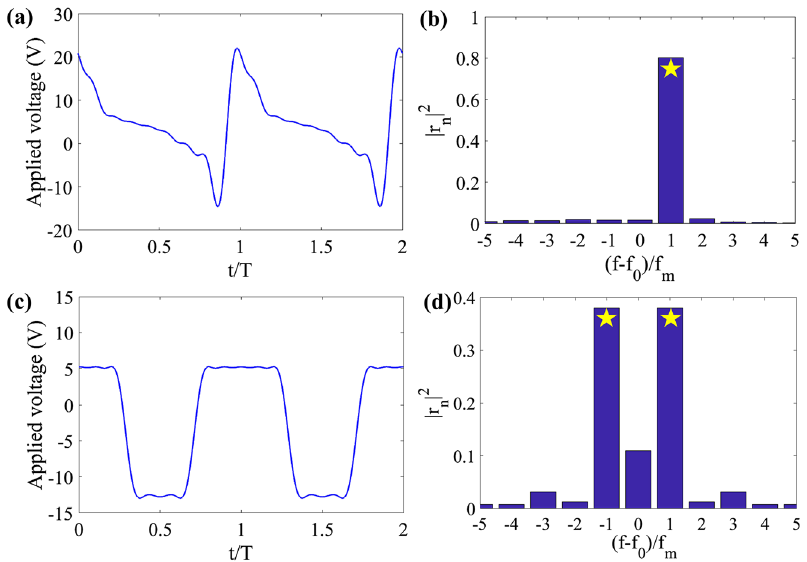
Figure 5: (a) The optimized modulation waveformand (b) thecalculatednormalized conversion ef fi ciency of the TMM to different frequency harmonics, correspondingtothecaseofpurefrequency mixing. (c) and (d) show the same for concurrent dual frequency generation. The desired mixing products are marked by star in the output spectra plotted in (c) and